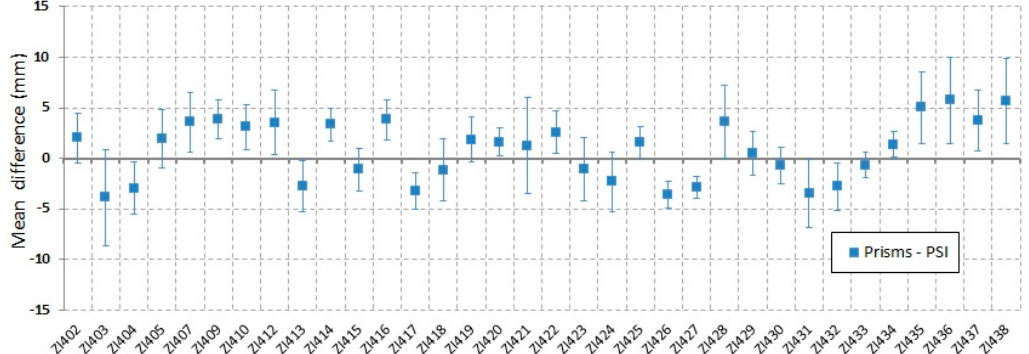
Figure 12. Mean difference and the standard deviation between the measurements of the two methods (Prisms minus PSI) during the period of 11 November 2015 to 15 May 2017 for the 34 points analysed in the main Germano dam.